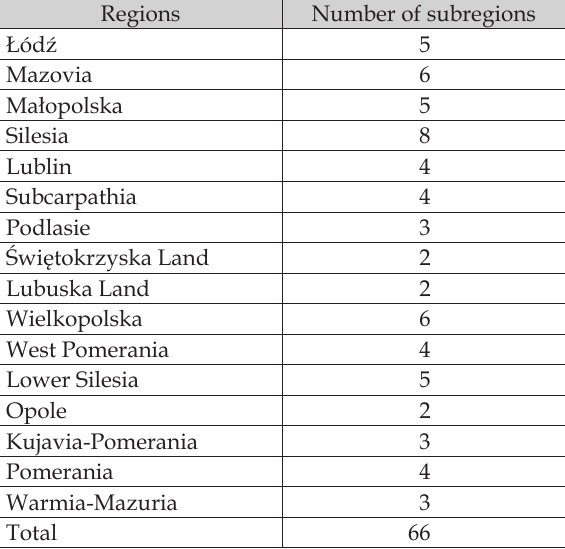
Table 1. Poland’s regions (voivodeships) and subregions.